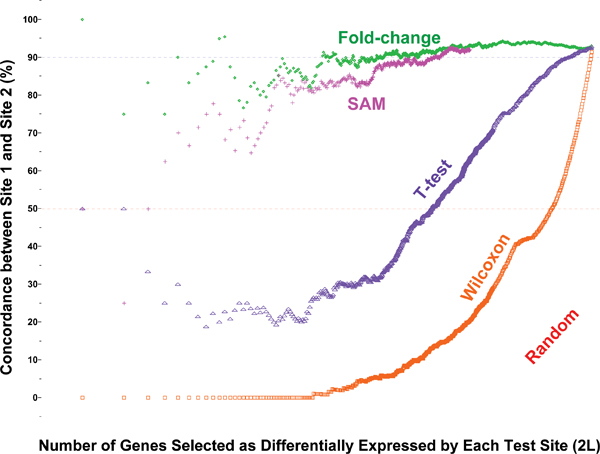
Inter-site concordance based on FC, t-test, Wilcoxon rank-sum test, and SAM. Affymetrix data on samples A and B from site 1 and site 2 for the "12,091" commonly mapped genes were used[13]. No flagged ("Absent") genes were excluded in the analysis. For the Wilcoxon rank-sum tests, there were many ties, i.e., many genes exhibited the same level of statistical significance because of the small sample sizes (five replicates for each group). The tied genes from each test site were broken (ranked) by random ordering. Concordance between genes selected completely by random choice is shown in red and reaches 50% when all candidate genes are declared as differentially expressed; the other 50% genes are in opposite regulation directions. SAM improves inter-site reproducibility compared to t-test, and approaches, but does not exceed that of fold-change.